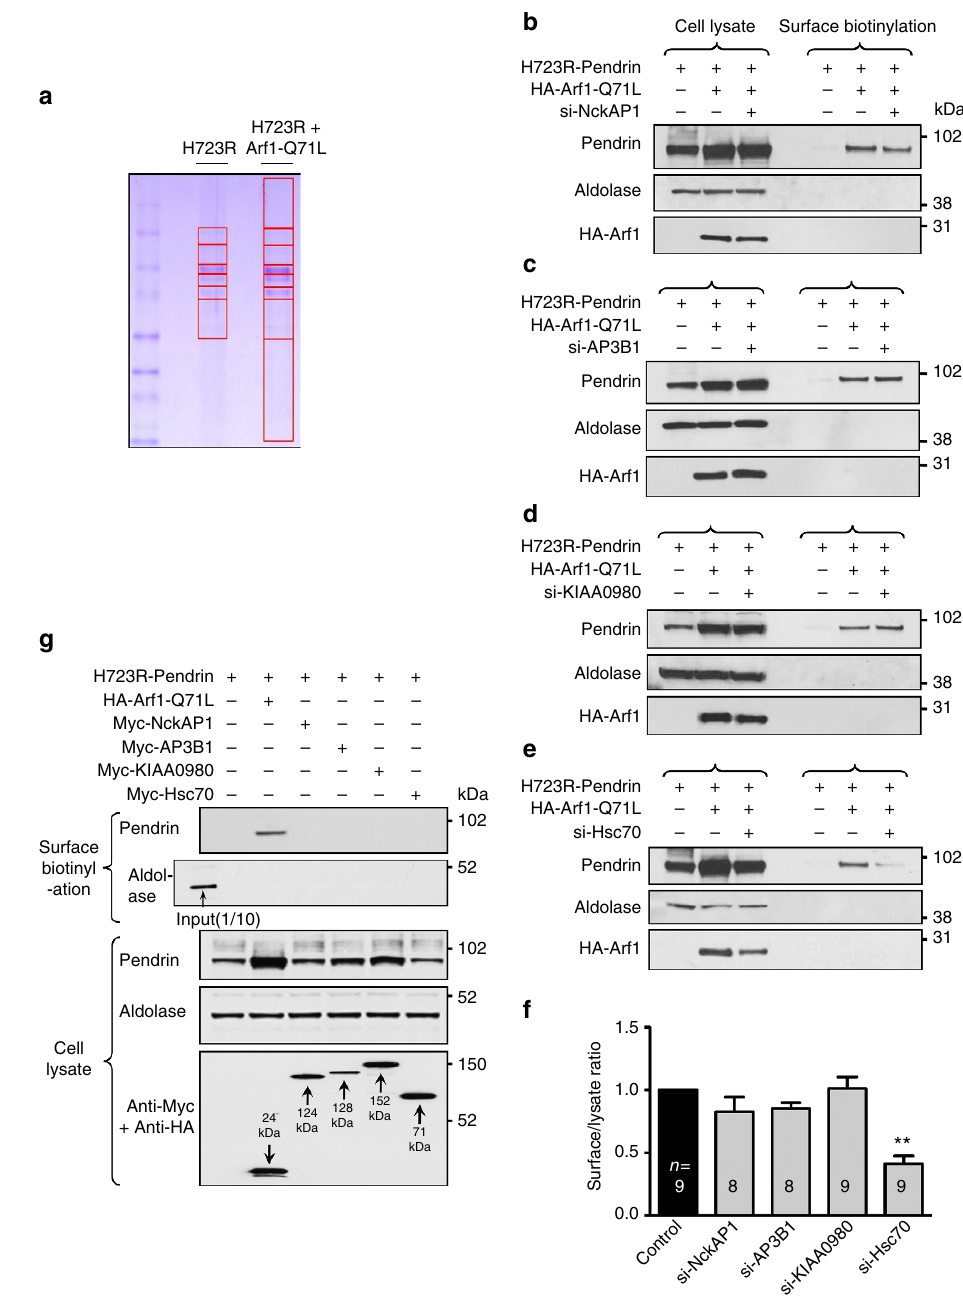
Figure 3 | Hsc70 is necessary for Arf1-Q71L–mediated unconventional cell-surface expression of H723R-pendrin. ( a ) After tandem affinity purification, binding partners of H723R-pendrin in PANC-1 cells with or without Arf1-Q71L co-expression were separated by electrophoresis. Subsequent analyses by LC-MS/MS identified NckAP1, AP3B1, KIAA0980 and Hsc70 as binding partners of H723R-pendrin (Supplementary Table 1). ( b – f ) Surface biotinylation assays were performed after siRNA-mediated knockdown of indicated candidate proteins. Representative blots are shown in b – e and a summary of multiple experiments is presented in f . Only treatment with siRNA targeting Hsc70 showed a significant effect. ** P o 0.01 by one-way analysis of variance, difference from control, the number of replicates ( n ) is presented in each lane. ( g ) Surface biotinylation assays were performed after overexpression of NckAP1, AP3B1, KIAA0980 and Hsc70. None of the candidate proteins induced cell-surface expression of H723R-pendrin. The data are representative of three independent experiments. Unprocessed original scans of western blots are shown in Supplementary Fig.